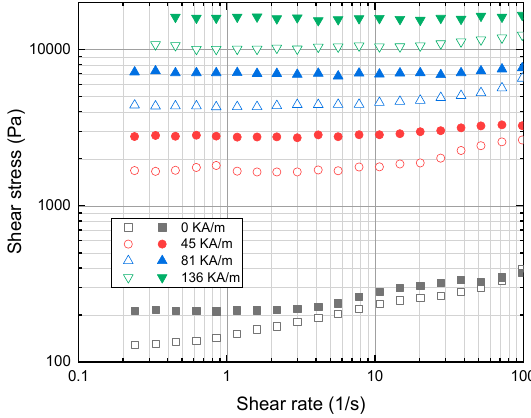
Figure 4. Shear stress as a function of shear rate for sunflower (open symbol) and cottonseed oil (closed symbol) blend-based MR fluid subjected to variable magnetic field i.e., 0, 45, 81 and 136 kA/m.